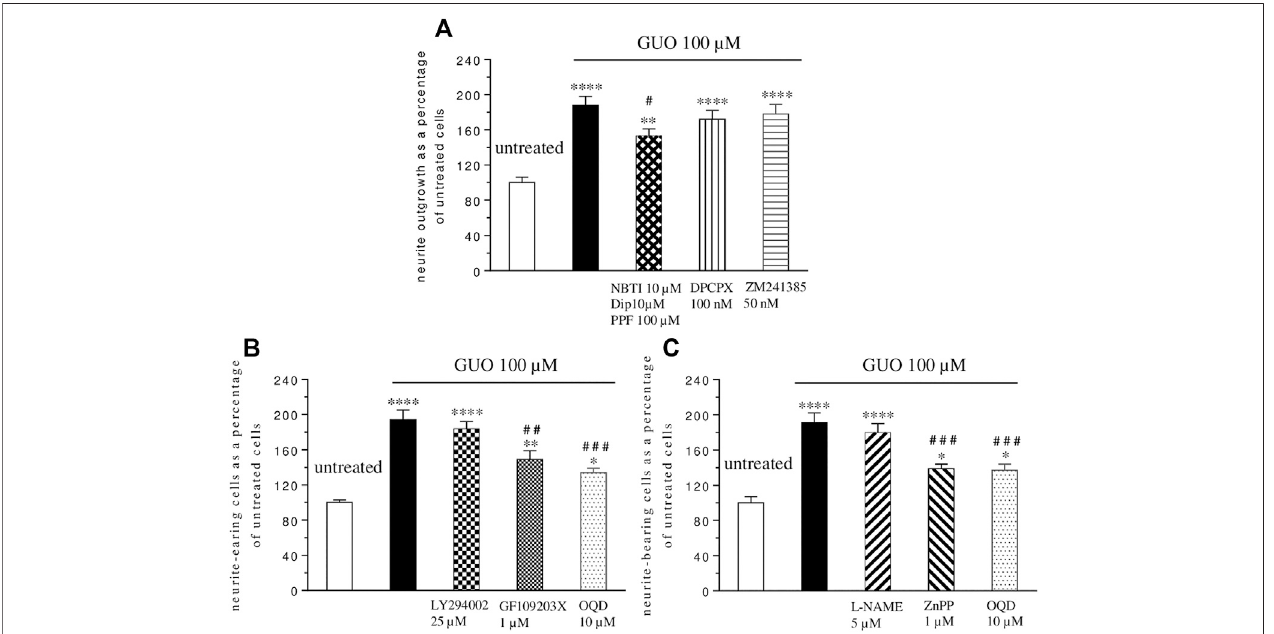
FIGURE 3 | Mechanisms involved in guanosine-induced SH-SY5Y neuroblastoma cell differentiation. (A) Nucleoside transporter blockers (10 µM NBTI plus 100 µM propentofylline – PPF-plus 10 µM dypiridamole -DIP-) were simultaneously added to the medium containing 1% serum 1 h before GUO (100 µM) treatment and untiltheendoftheexperiment(48 h),whiletheantagonistofA 1 andA 2A adenosinereceptor,DPCPX(100 nM)andZM241385(50 nM),respectively,wereadded30 min before and until the end of the 48 h GUO (100 µM) treatment period. (B) The selective inhibitors of PI3K (25 µM LY294002), PKC (1 µM GF109203X), and sGC (10 µMOQD)or (C) theselectiveinhibitorsofNOS(5 μ ML-NAME),HO(1 µMZnPP)andsGC(10 µMOQD)wereaddedtoculturesbeforetheadditionofGUO(100 µM) andduringalltheGUOtreatment.Inallcases,after48 h,thetotalnumberofneurite-bearingcellswasdetermined.Eachvaluerepresentsthemean ± SEMofatleast fi ve independent experiments in duplicate and is expressed as a percentage of neurite-bearing cells vs. untreated cells. Statistical analysis was performed using one-way ANOVAwiththeDunnett ’ sorTurkey ’ spost-hocmultiplecomparisonstest;* p < 0.05,** p < 0.02,**** p < 0.001comparedwithuntreatedcells;# p < 0.05,## p < 0.02,## # p < 0.01 compared with GUO treated